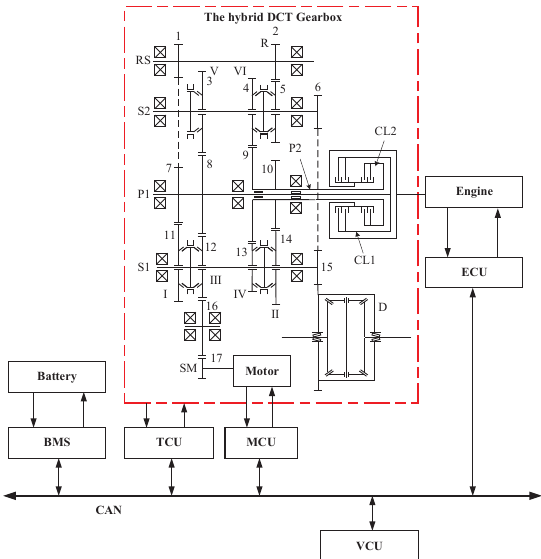
Figure 2. The hybrid DCT powertrain system over a controller area network